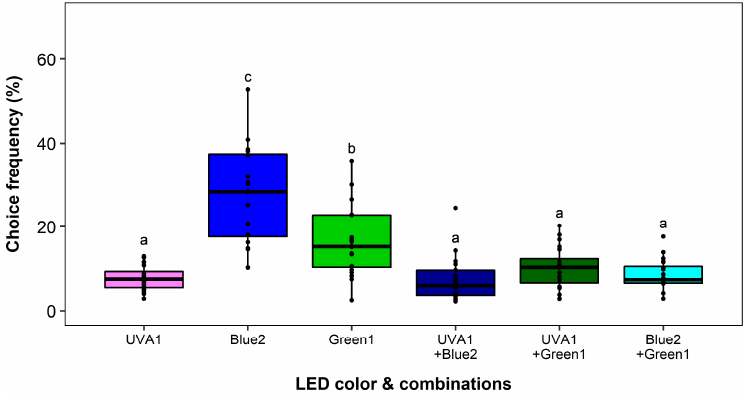
Figure 8. Wavelength preferences of Frankliniella occidentalis in multiple-choice experiment with ultraviolet, blue and green light-emitting diodes (LEDs) and respective combinations with adjusted equal intensities. See Table 1 and Figure 2 for LED specifications. Significant di ff erences are